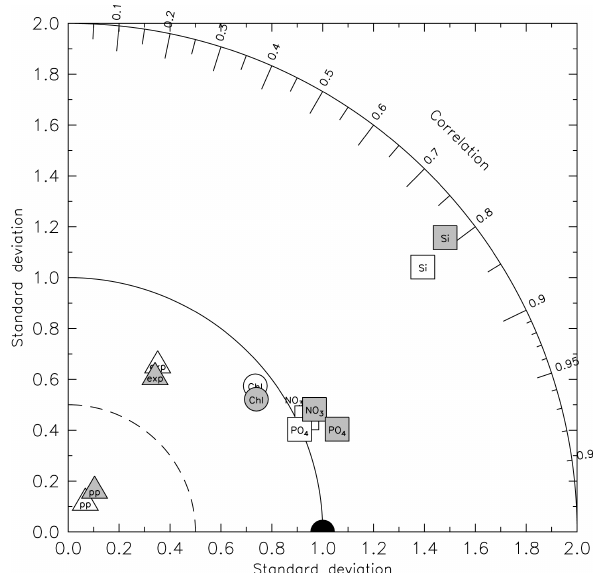
Figure 8. Taylor diagram comparing the distributions of surface concentration in annual mean Chl, NO 3 , PO 3 , Si, primary produc- tion (pp) and export production (exp) for PlankTOM10 (in grey) and PlankTOM6 (in white) with observations. Chl, biomass and nutrient observations are as in Fig. 3. Export production is from (Schlitzer, 2004) and represents annual mean flux at 100m. Primary production is from Buitenhuis et al. (2013a) and includes monthly mean values for the surface 300m. The black dot shows the loca- tion where the model results should be if it was perfect and there were no errors in the observations. The distance from the black dot quantifies the performance of the model (Taylor,